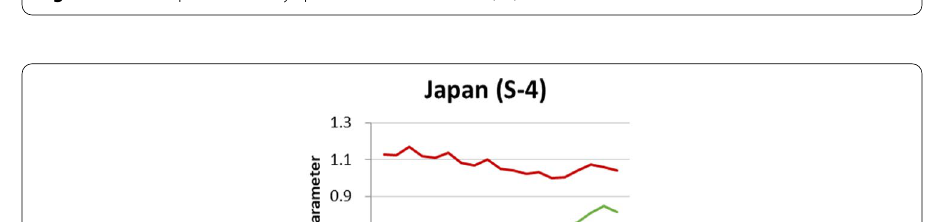
Fig. 4 Estimated parameters by quantile for S-3 markets (LB)